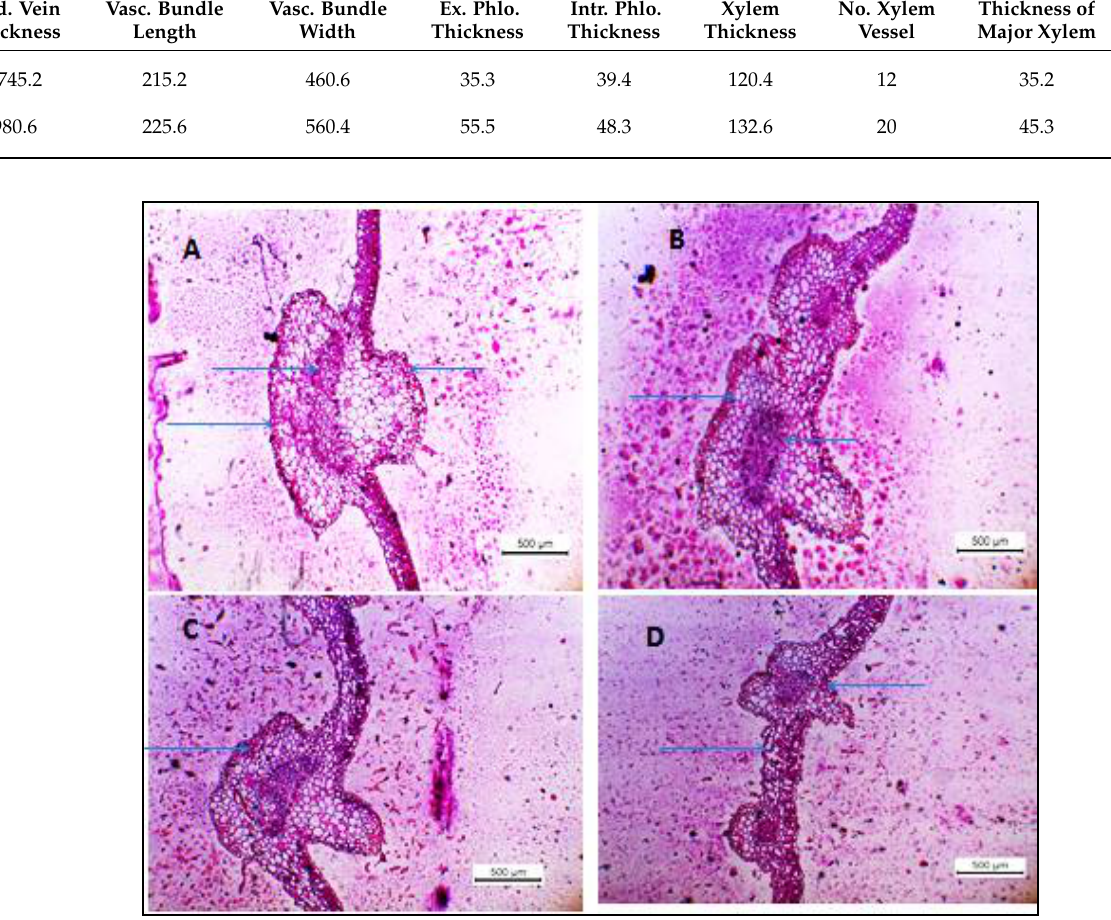
Figure 8. Anatomical alterations in potato leaves treated with nanoparticles; (100× and D 60×). ( A ): healthy, ( B ): precipitation of lignin in sub stomatal cavity, ( C ): mesophyll cells showing folding and layering of cell walls, ( D ): tissue showing intense staining and increasing number of xylem vessels. Table 2. (A ). Anatomical properties of potato leaves treated with chitosan (CS-NPs); ( B ). vascular bundle and xylem (µm) properties of potato leaves treated with chitosan (CS-NPs).